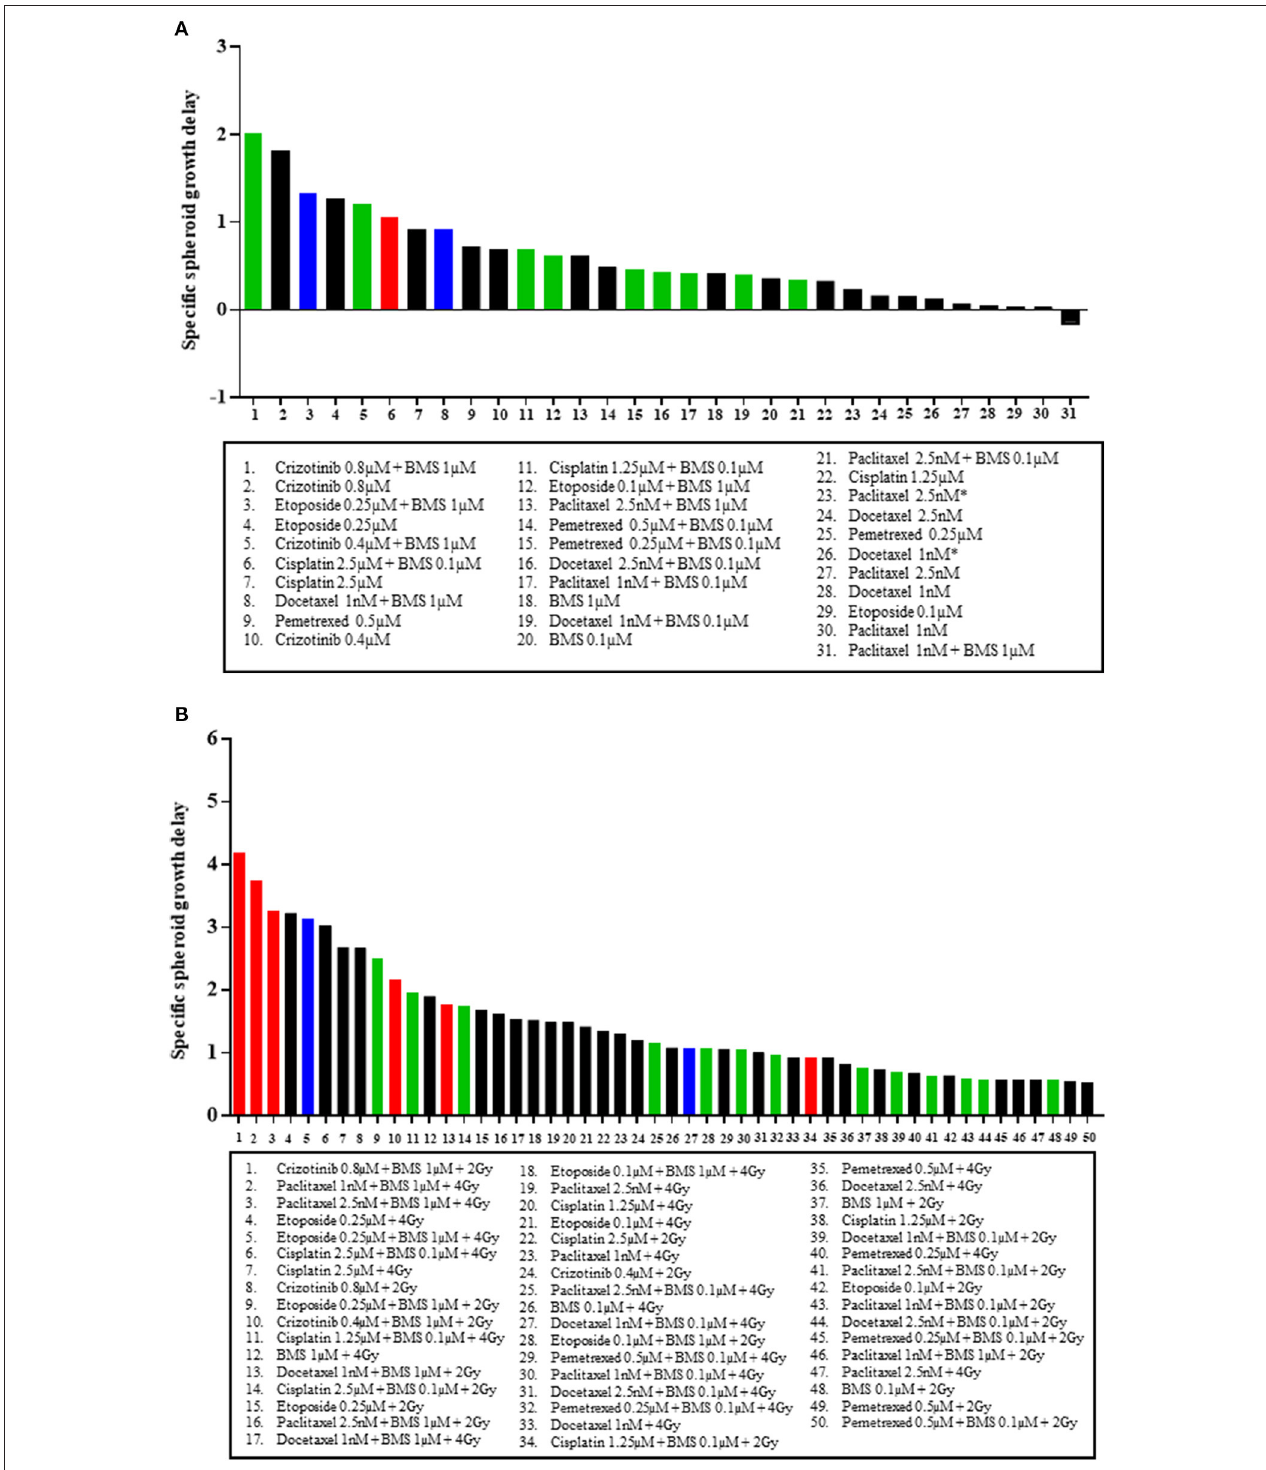
FIGURE 4 | Top ranking treatment combinations in NSCLC multicellular spheroids. Comparisons in multicellular NCI-H1299 spheroids of: (A) chemotherapeutic at dose specified, and chemotherapeutic plus 0.1 or 1 µ M BMS-906024; and (B) chemoradiation (with 2 or 4Gy), and chemoradiation plus 0.1 or 1 µ M BMS-906024. Red bars indicate that the addition of BMS-906024 to that treatment option conferred a statistically significant SSGD compared to the treatment without BMS-906024, and the interaction was synergistic. Green bars indicate only statistically significant SSGD. Blue bars indicate only synergistic interaction. Black bars indicate non-significant